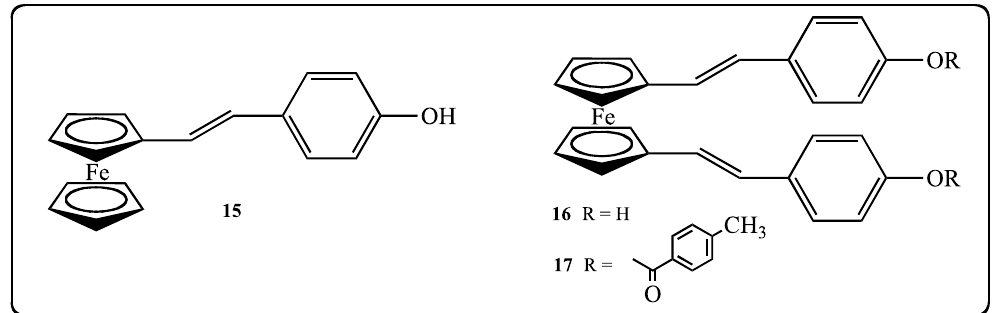
Figure 3. Molecular structure of ferrocenyl-stilbene analogs 15 – 17